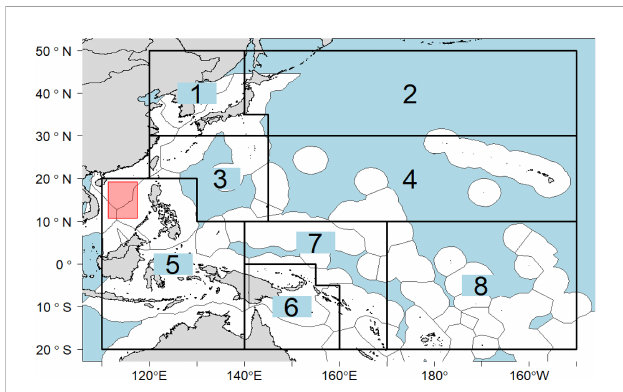
FIGURE 1 Eight (1 – 8) WCPO skipjack tuna stock assessment regions (sourced WCPFC, available online at https://www.wcpfc.int/doc/03/skipjack- tuna ). The red rectangle represents the South China Sea skipjack tuna sampling